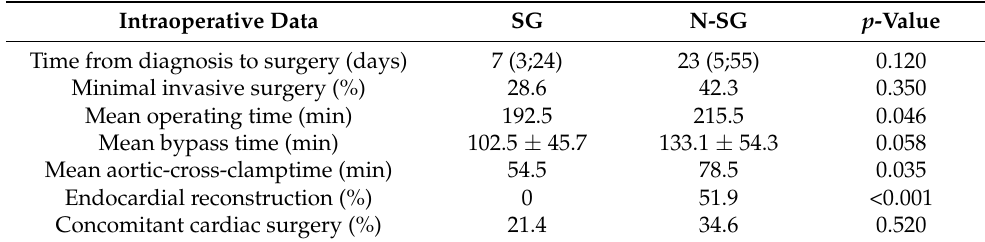
Table 5. Intraoperative data.